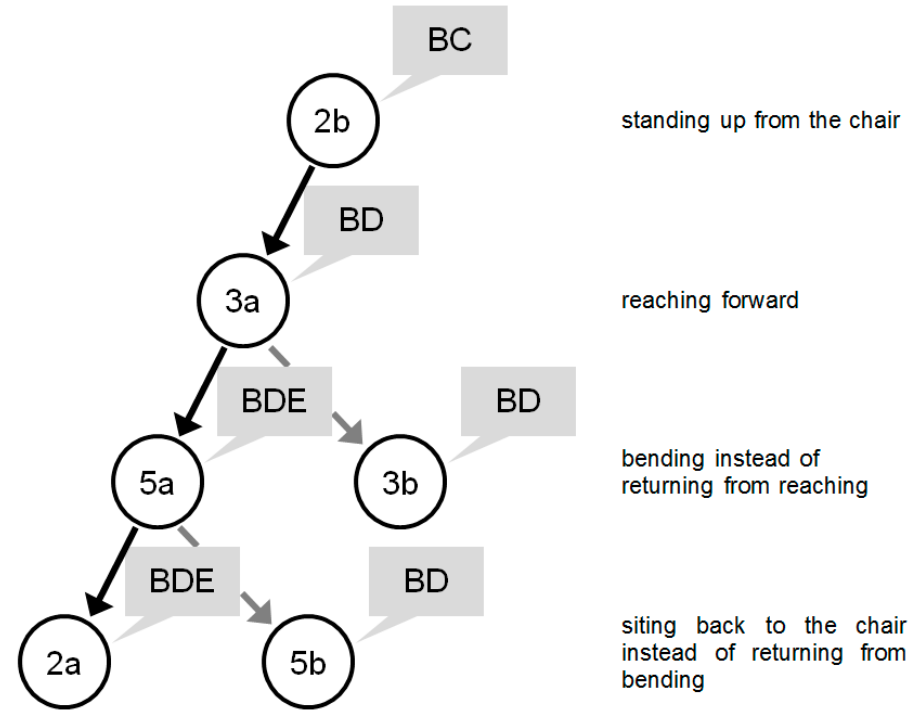
Figure 8. Activities performed in example 7.4 (activities are listed in circles and sensors in grayed rectangles) with unexpected activities and system decisions: at (5a) sensor E is included additionally and at (2a) the usage of sensor E is maintained.